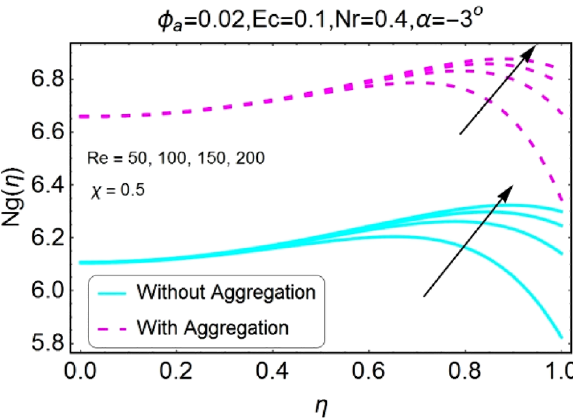
Figure 47. Re varying Ng for stretching walls (convergent channel).